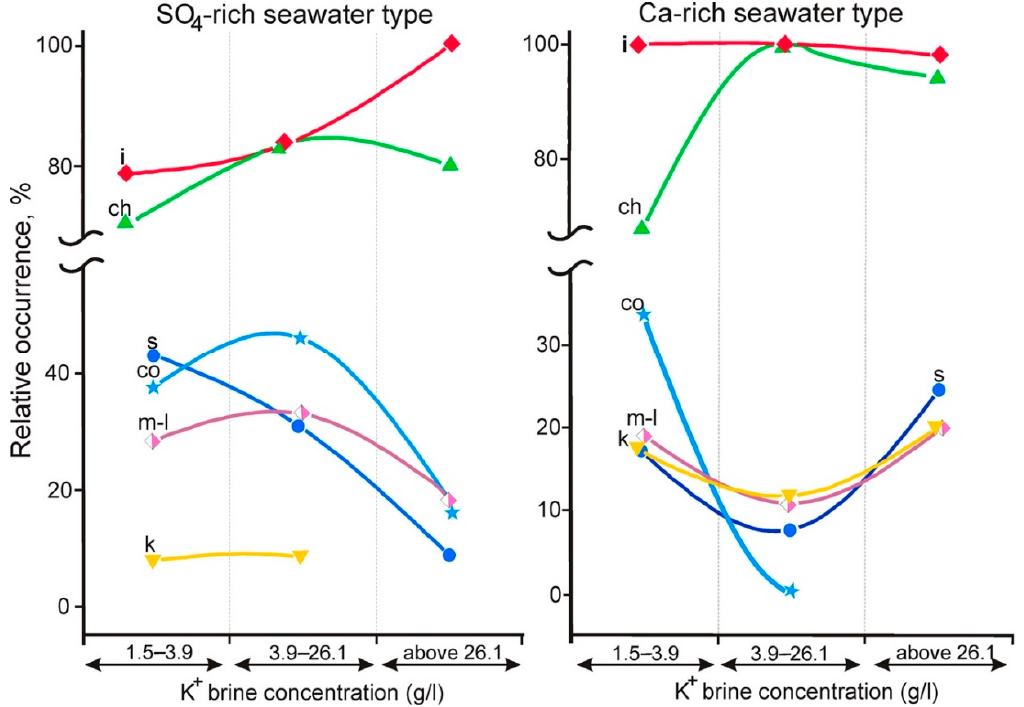
Figure 3. Relative occurrence of clay minerals that take part in transformations at different stages of brine concentration (concentration ranges for different stages after [96]); ch—chlorite, co—corrensite, i—illite, k—kaolinite, m-l—mixed-layer minerals, s—smectite.